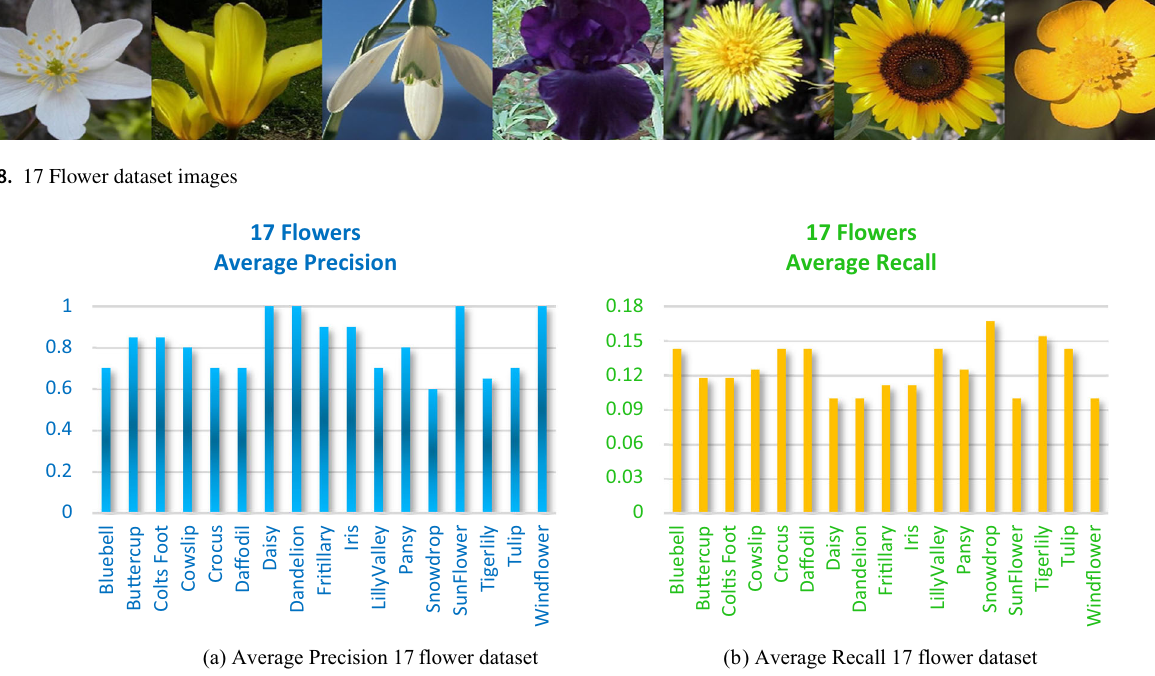
(a) Average Precision 17 flower dataset (b) Average Recall 17 flower dataset Fig. 9 a Average precision 17 flower dataset. b Average recall 17 flower dataset